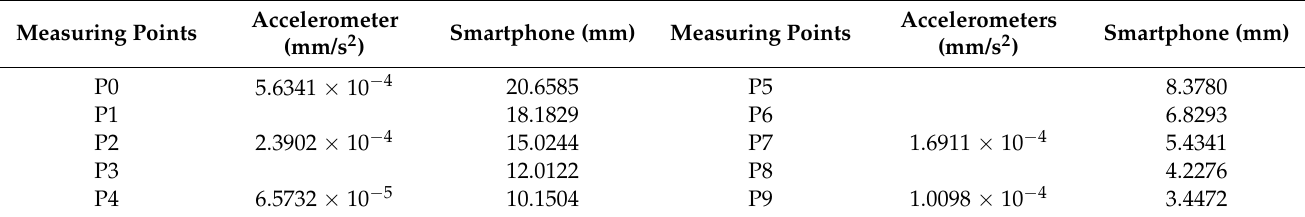
Table 4. Response peak value obtained by two monitoring methods.